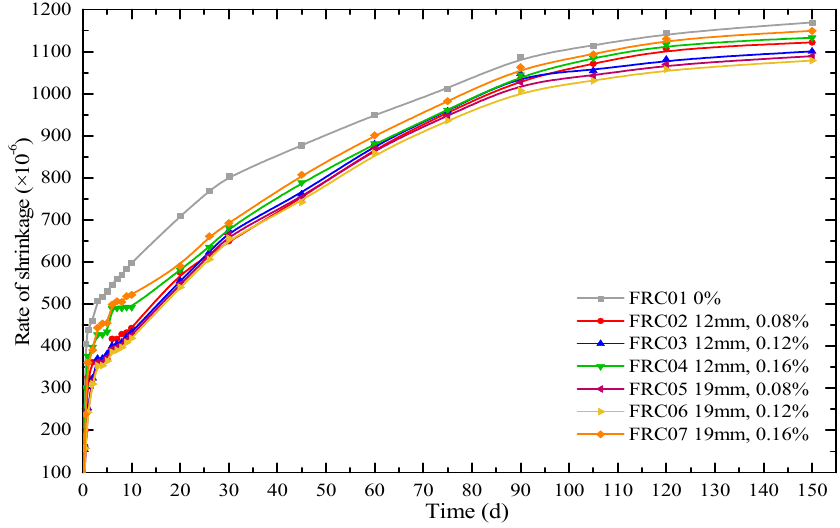
Figure 18. Free shrinkage deformation of the concrete specimens during 150 days.